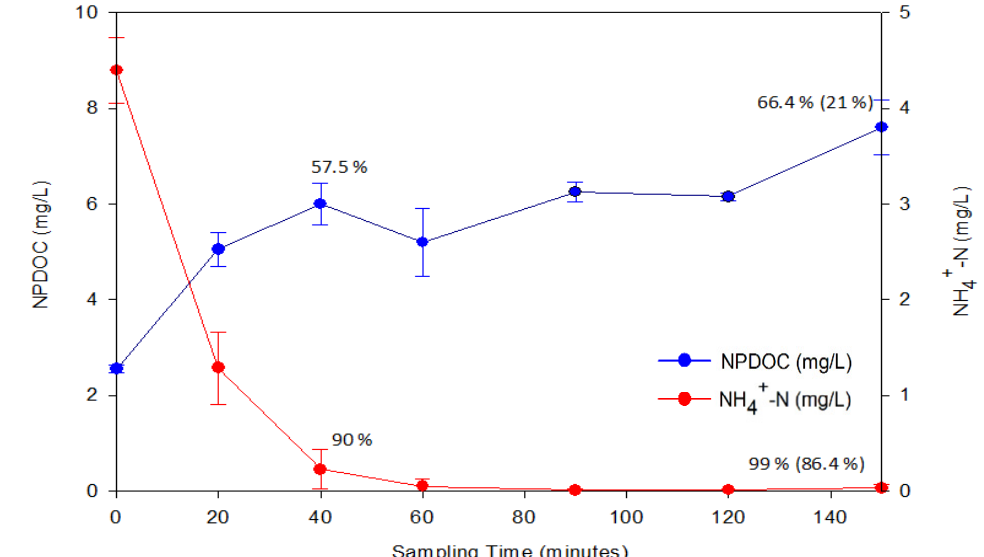
+ -N and NPDOC concentrations during the nitrification operation of bionet filter Fig. 1: The variations of NH 4 (Initial ammonium concentration =5